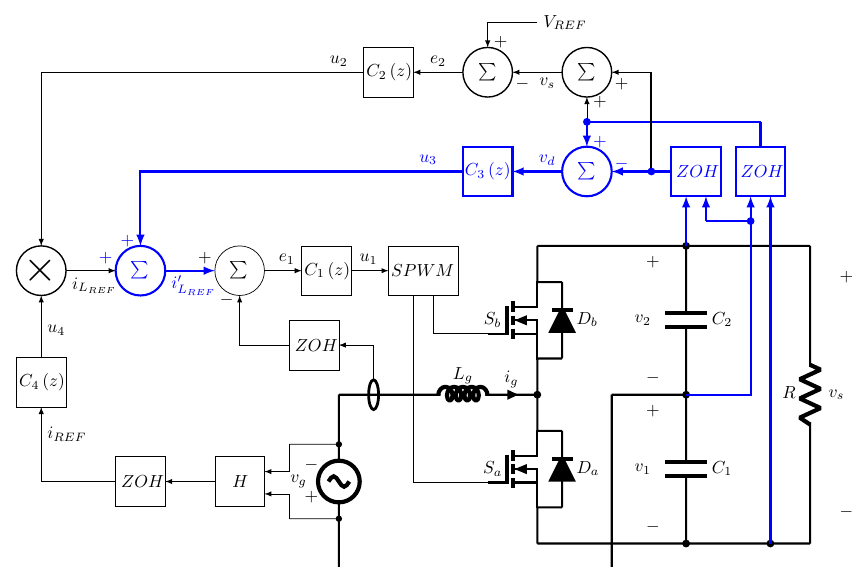
Figure 1. Control diagram with differential voltage loop for a converter with power factor correction in half-bridge configuration.